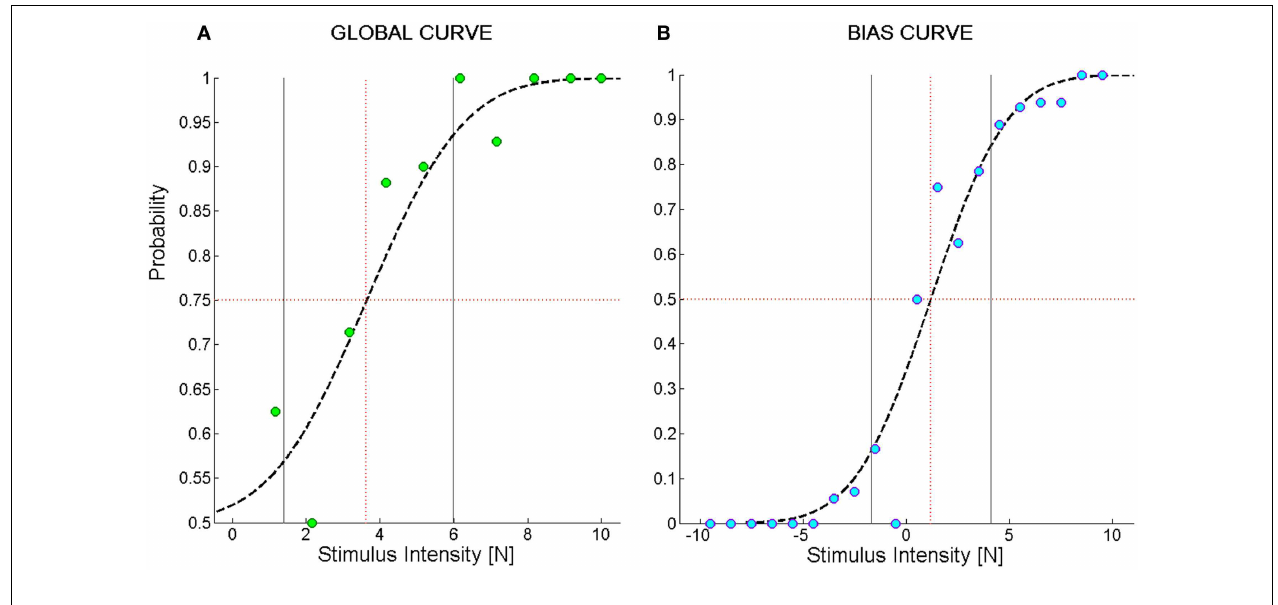
stimulus in the correct direction over bins of 1N. Subject’s responses were fit to a logistic function (dashed black line).The black vertical lines represent the interval of stimuli one standard deviation far from the mean of the Gaussian probability function used to fit the data.We called this interval Spread .The red dotted vertical lines identify the stimulus corresponding to its mean value that we named F 85 for (A) and Bias Level for (B)